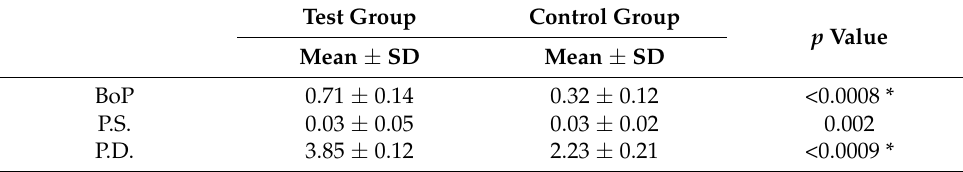
Table 6. Peri-implant parameters among test group and control group pre-treatment. Test Group Control Group Mean ± SD Mean ± SD BoP 2.14 ± 0.49 2.16 ± 0.51 <0.014 * P.S.